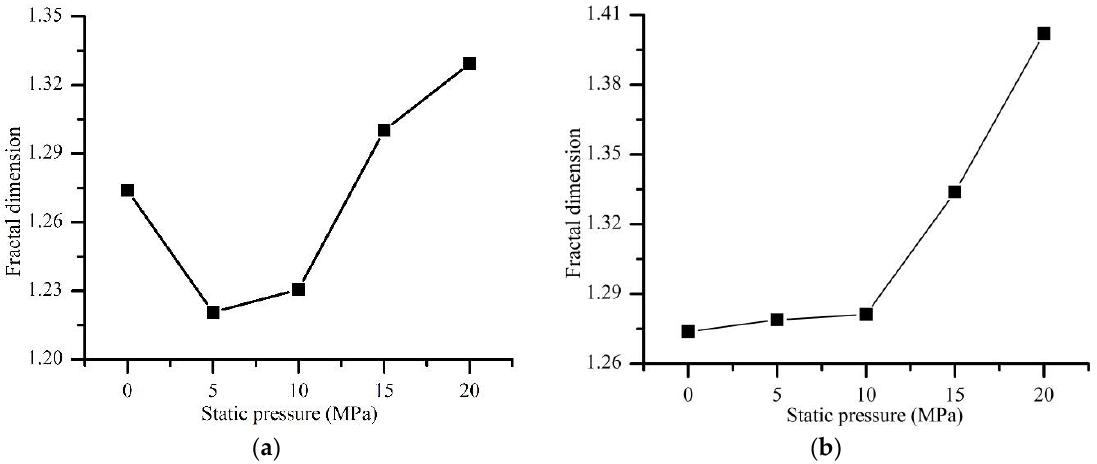
Figure 17. The change of fractal dimension with static pressure: ( a ) Group I; ( b ) Group II.